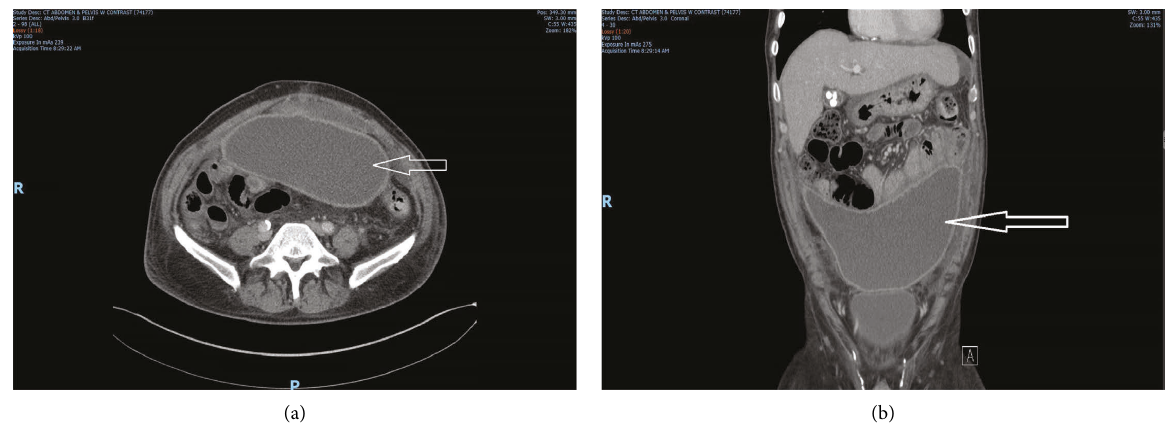
Figure 1: (a) Computed tomography (CT) abdomen/pelvis cross sectional view showing rim-enhancing fluid collection in the anterior peritoneal cavity measuring 22 × 13 × 7.2 cm representing intraabdominal abscess. (b) Computed tomography (CT) abdomen/pelvis coronal view showing rim-enhancing fluid collection in the anterior peritoneal cavity measuring 22 × 13 × 7.2cm representing intraabdominal